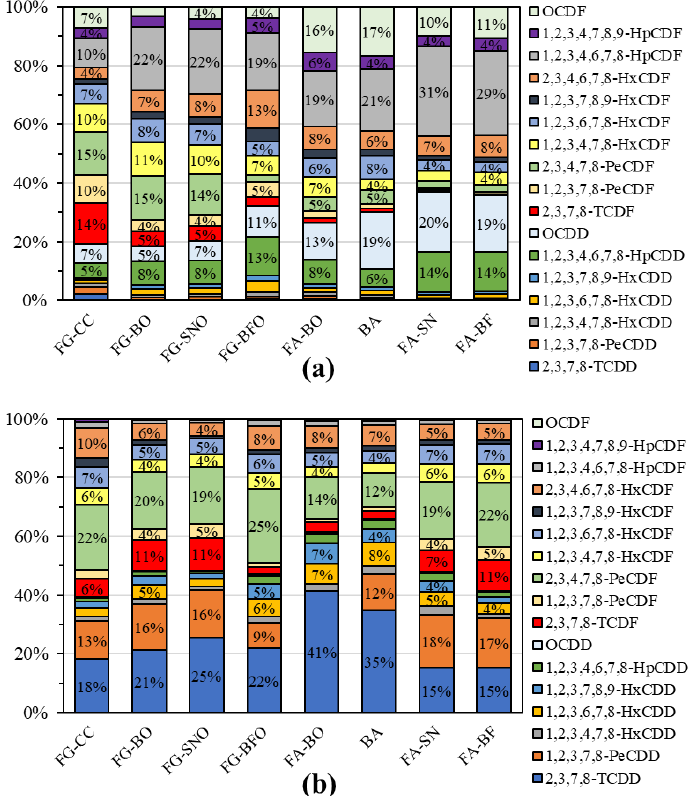
Figure 3. Distribution of 17 kinds of toxic PCDD/Fs in FG, FA and BA from leather waste incinera- tion: ( a ) fingerprint of total toxic PCDD/Fs; ( b ) fingerprint of toxic PCDD/Fs on I-TEQ level.